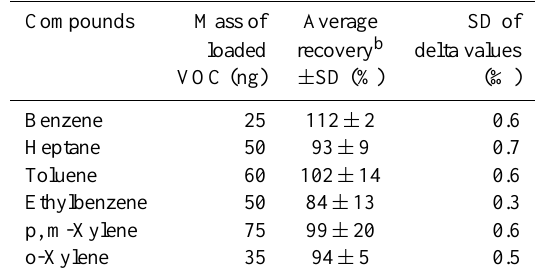
Table 3. Average recoveries a of VOCs sampled on cartridges for desorption at 553K for 40min at (60 to 80) mLmin − 1 carrier gas flow rate.